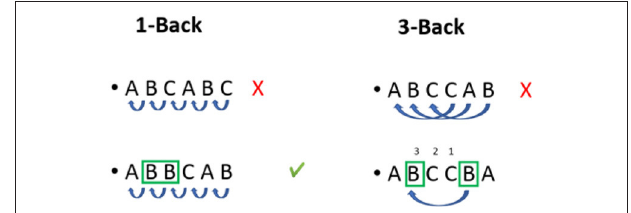
FIGURE 1 | Illustration of the N-back task operation according to the difficulty modality (1-back vs. 3-back).